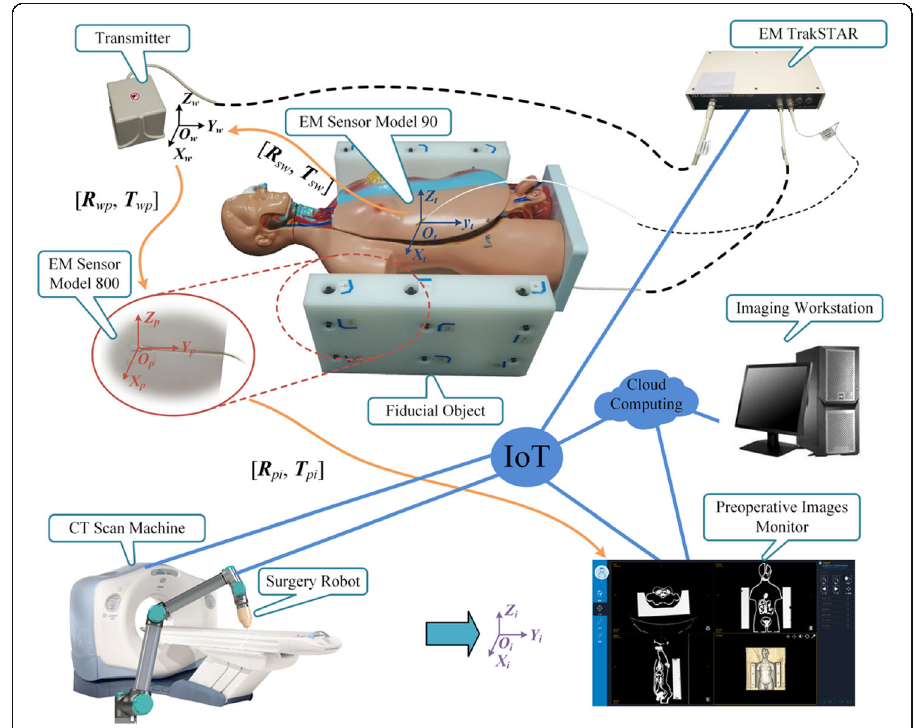
Fig. 7 Electromagnetic navigation system and the coordinate transformations involved in spatial registration in the IoT operating